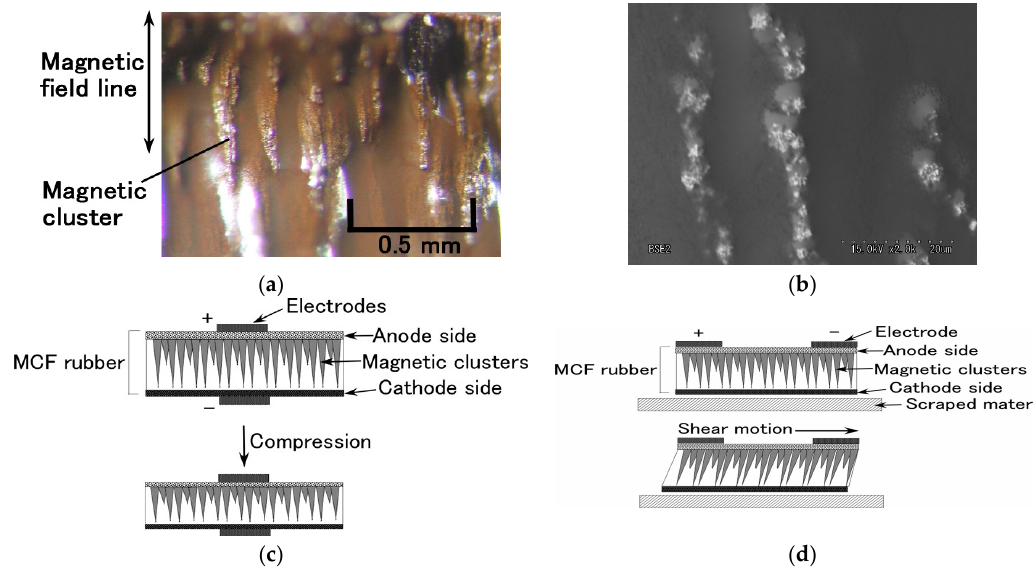
Figure A1. Cross section of electrolytically polymerized MCF rubber: ( a ) microscopic image of magnetic clusters [31]; ( b ) image magnifying a part of needle-like magnetic cluster in ( a ) by SEM, ×2000; ( c ) schematic diagram of MCF rubber transformed by compression [31]; ( d ) schematic diagram of transformed MCF rubber by shear force.